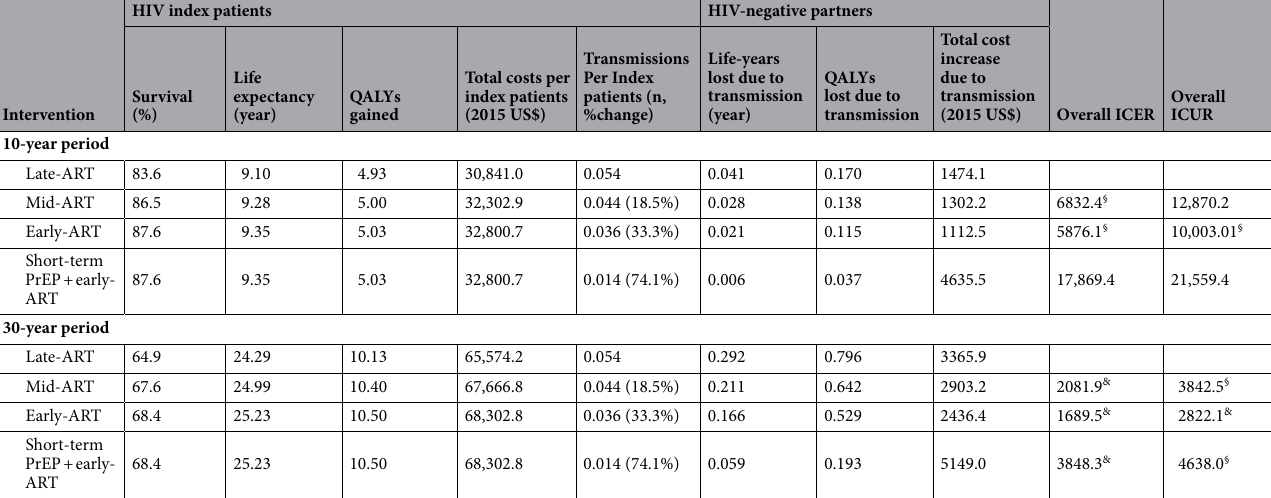
Table 2. Life expectancy, HIV transmission, costs, cost-effectiveness and cost-utility over 10-year horizon and 30-year horizon respectively. Life expectancy for the 10-year and 30-year period indicates the average duration of survival through 10 years and 30 years, respectively. QALYs gained for the 10-year and 30-year period indicate the average accumulative QALYs through 10 years and 30 years, respectively. The overall ICER (overall incremental cost-effectiveness ratio) was calculated as the difference in costs for the index patient plus the difference in the increased costs for HIV-negative partners due to transmission and PrEP drugs divided by the difference in life expectancy for the index patients plus the difference in life-years lost due to transmission, all discounted at 3% per year. The overall ICUR (overall incremental cost-utility ratio) was calculated as the difference in costs for the index patient plus the difference in the increased costs for HIV-negative partners due to transmission and PrEP drugs divided by the difference in QALYs for the index patients plus the difference in QALYs lost due to transmission, all discounted at 3% per year. § This indicates the values were lower than the cost-effective threshold. & This indicates the values were lower than the very cost-effective